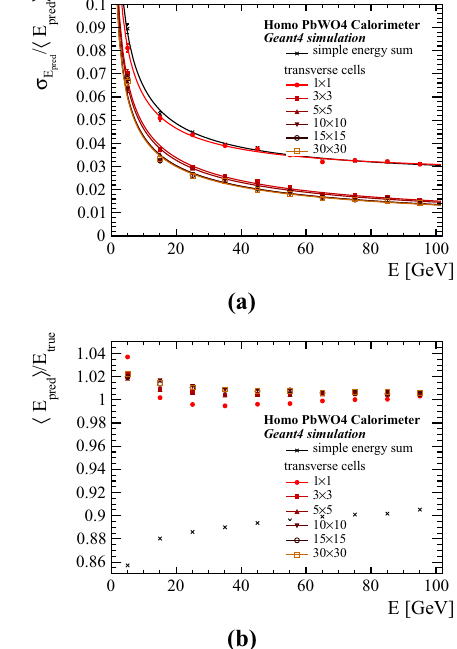
Fig. 5 a A 3D view of a 35GeV pion shower in the homogeneous PbWO 4 calorimeter at the finest granularity. The color code as well as the box sizes correspond to the amount of energy recorded in the calorimeter cells. b A front view of the average pion shower at 35GeV over 2646 events, with a grid overlaid corresponding to the coarsest applied transverse segmentation and an original binning corresponding to the finest segmentation